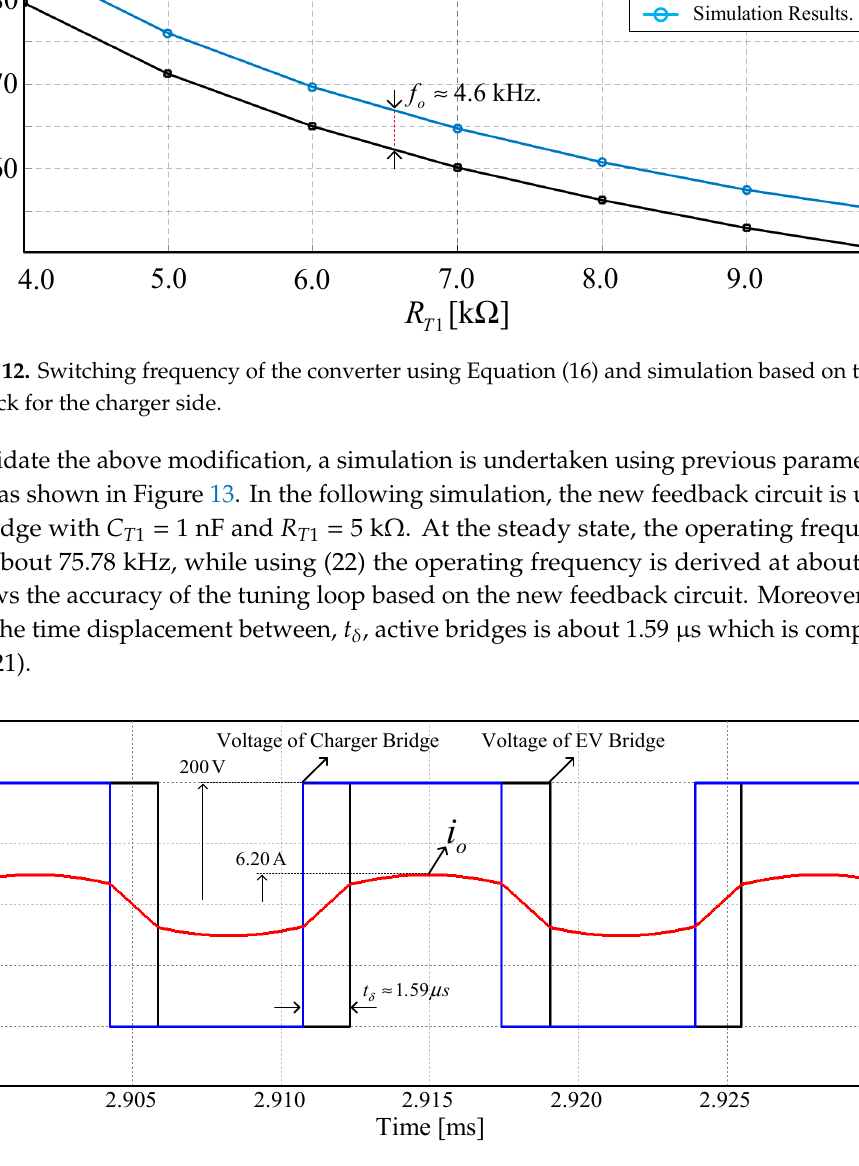
Figure 13. Output voltage of the charger bridge, EV bridge and i o under equal voltages condition with τ 1 = 5 µs and τ 2 = 1µs while the charger side is controlled based on the new feedback circuit.